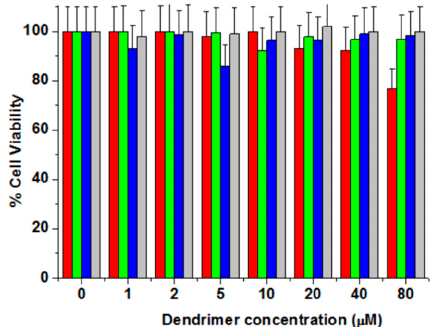
Figure 4. Cell Viability of empty Janus dendrimers in Huh 5-2 cell line. All the data are presented as the average ± standard deviation. (NH 3 + ) 8 [GMPA]-[MPA](C17) 2 (Red Bars), (NH 3 + ) 8 [GMPA]-[MPA](C17) 4 (Green Bars), (NH 3 + ) 8 [MPA]-[GMPA](C17) 2 (Blue Bars), (NH 3 + ) 8 [MPA]-[GMPA](C17) 4 (Gray Bars).